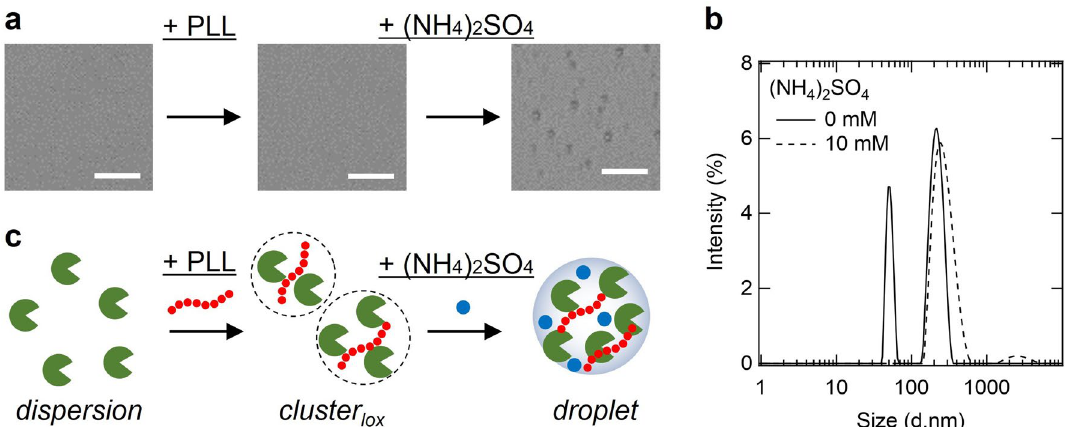
Figure 1. LOX assembly states in the presence of PLL and (NH 4 ) 2 SO 4 . ( a ) Microscopy images of 0.1 µM LOX, 20 mM Tris–HCl (pH 8), 0 or 0.02 mM PLL (concentrations refer to lysine monomer units), 0 or 10 mM (NH 4 ) 2 SO 4 . Scale bar, 10 µm ( b ) DLS data of sample solutions containing 0.1 µM LOX, 0.02 mM PLL, 20 mM Tris–HCl (pH 8), with 0 or 10 mM (NH 4 ) 2 SO 4 . ( c ) Schematic image of assembly states of LOX with PLL and (NH 4 ) 2 SO 4